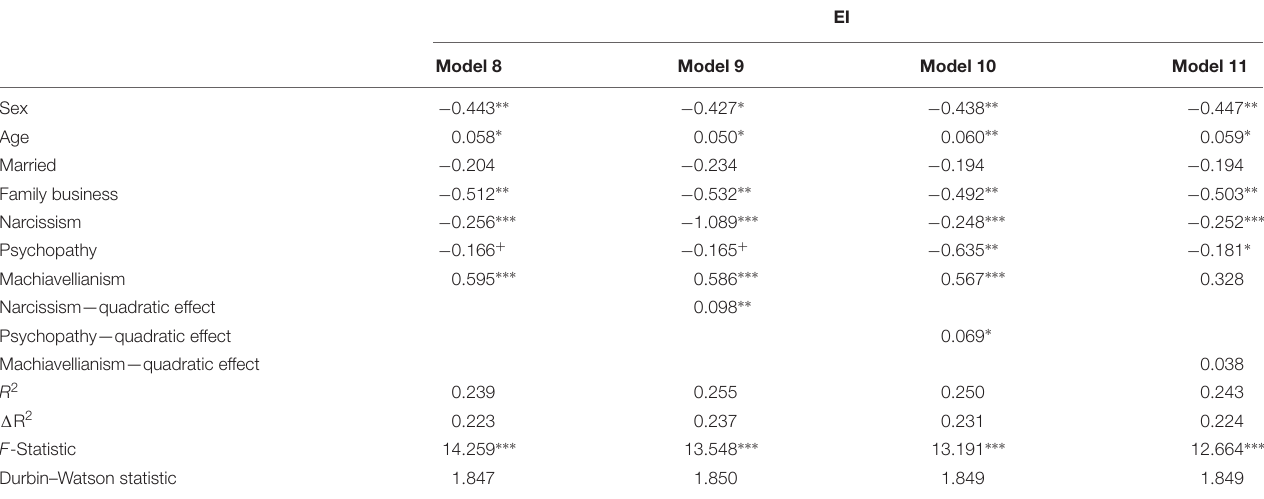
TABLE 4 | Examining the non-linear relationship between the dark triad and entrepreneurial